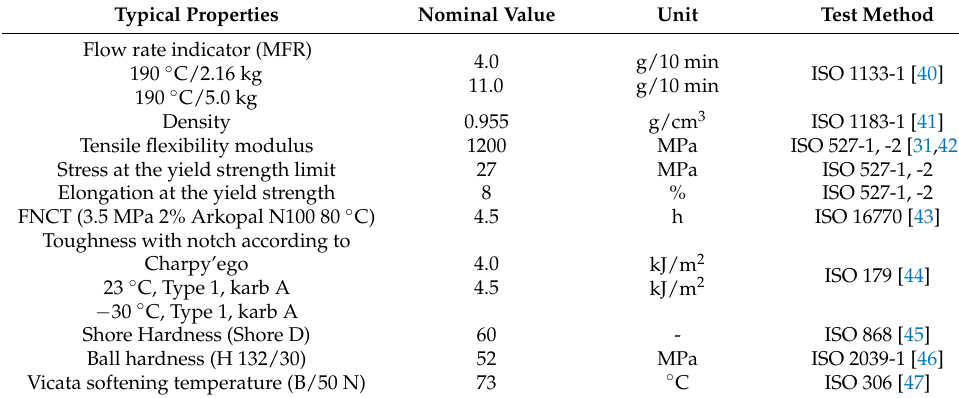
Table 12. Typical properties of the plastic from which the airfield geocell is made of. Typical